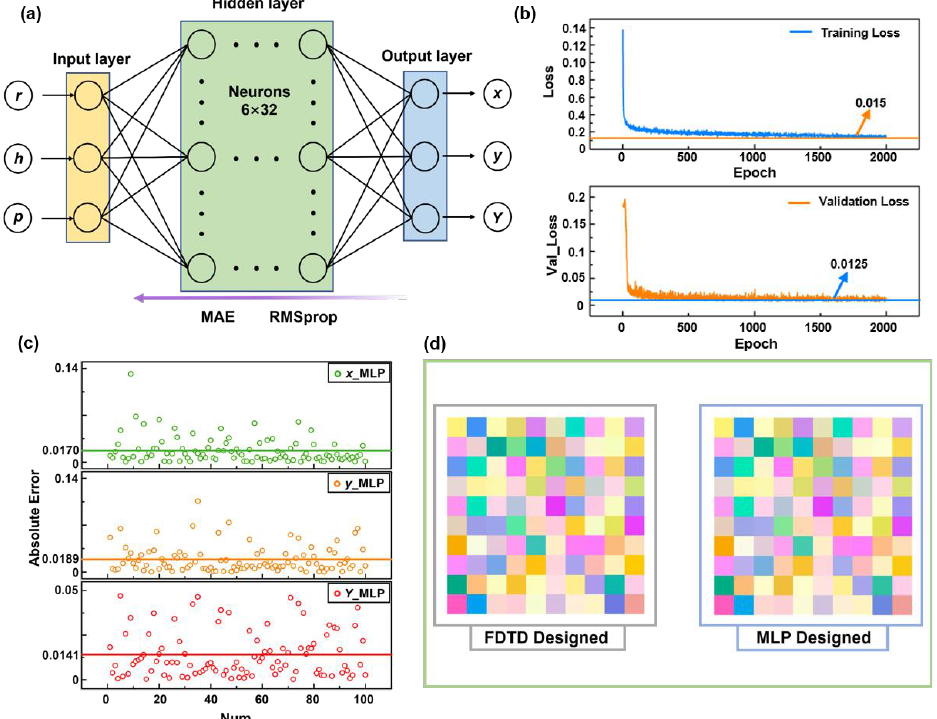
Figure 3. ( a ) Schematic of the MLP for predicting Si structural colors. ( b ) The loss function of training loss and validation loss in the MLP training process. ( c ) The absolute error between 100 groups of calculated color values and MLP predicted color values. ( d ) Comparison between 100 groups of real color and predicted color display.